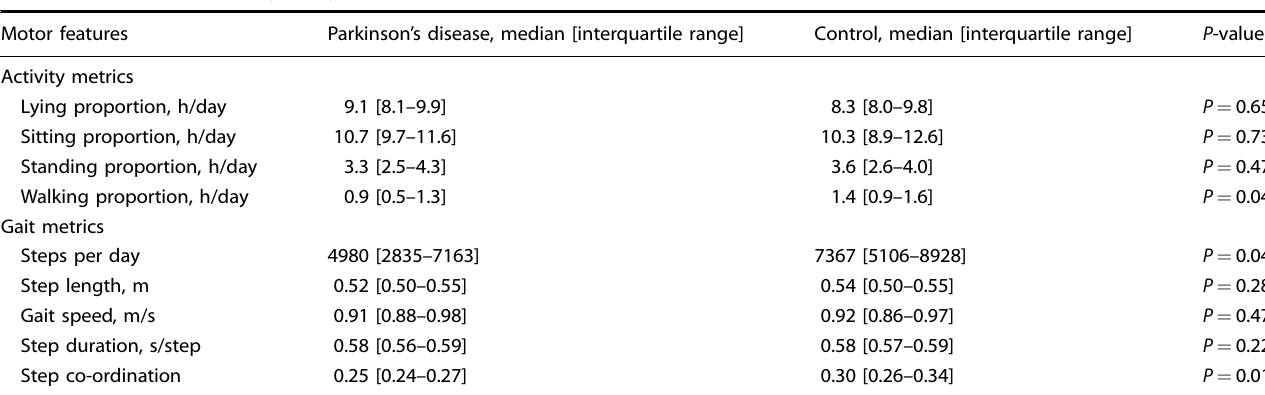
were slightly lower for PD than controls. Cross-correlation analysis quanti fi ed the inter-leg coordination, which was lower for individuals with PD than controls.